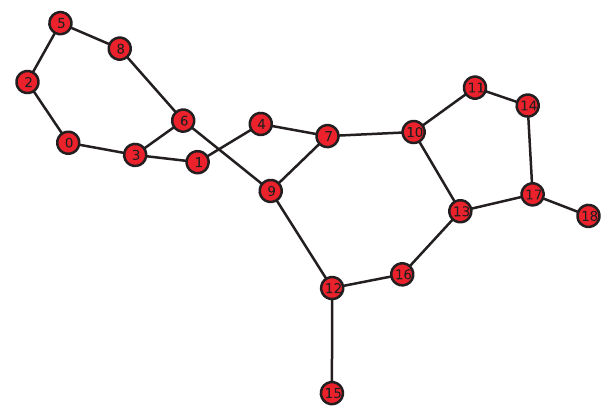
Figure 5. Example Graph G with I orb ( G ) ~~~~~~~~~ 1 and relatively small I l